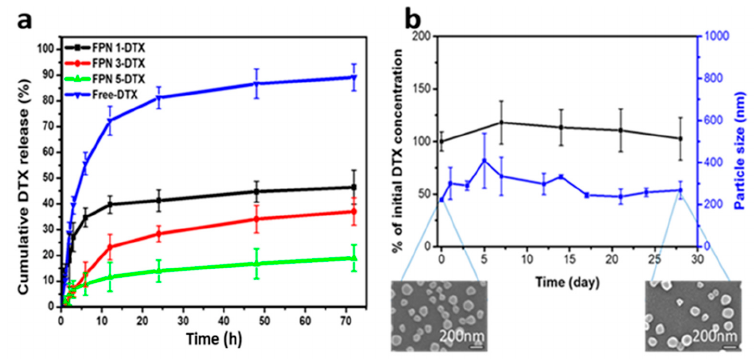
Figure 4. ( a ) Cumulative DTX release from FPN 1-DTX, FPN 3-DTX, FPN 5-DTX, and free DTX. ( b